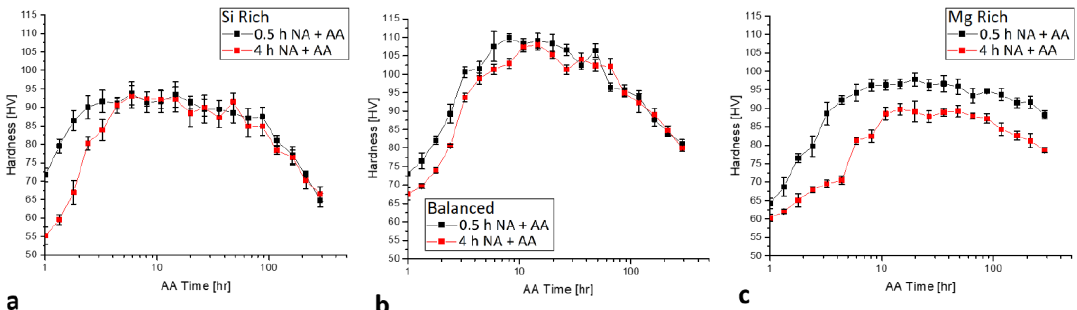
Figure 3. Hardness evolutions during artificial aging (AA) in high strength alloys of Si-rich ( a ); balanced ( b ); and Mg-rich ( c ) compositions. Prior to AA, samples were water quenched from ST (solution treatment) and naturally aged for either 0.5 or 4 h. Error bars represent 95% confidence intervals.